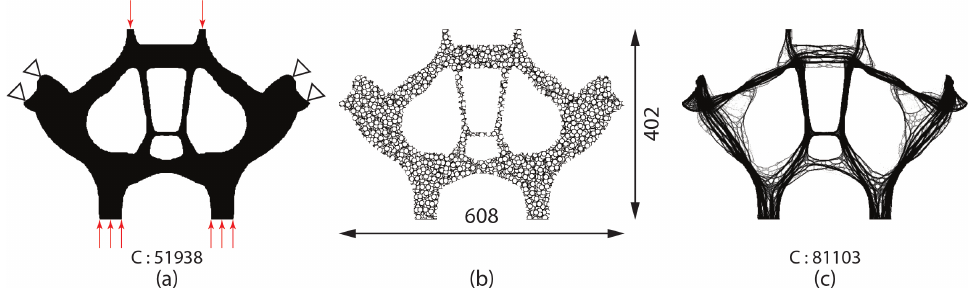
Figure 12. Geometric complexity control using perimeter control constraint [43]. ( a ) Cross-section of midface across first molar teeth, ( b ) initial configuration generated by randomly locating circles in the design domain ( P = 46,187), ( c ) topology optimized internal geometry ( P min = 30,000). A 60% increase in the compliance is observed while achieving 80% volume (weight) reduction.